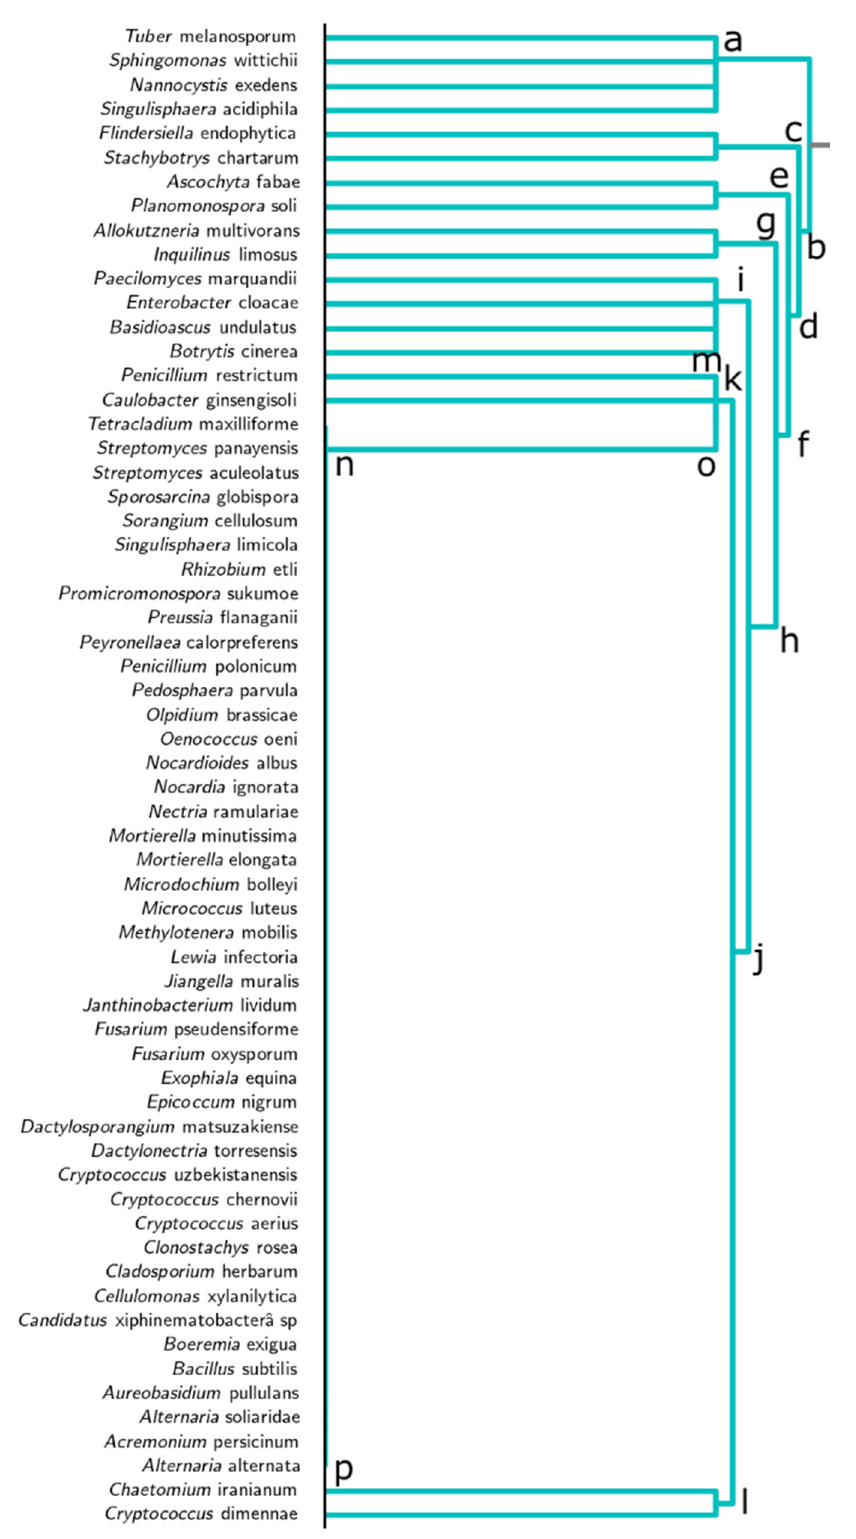
Figure 4. Dendrogram of the relationship between T. melanosporum and other fungal and bacterial species obtained by Russell & Rao coefficient and UPGMA. N. The dendrogram can be read as showing which species cluster together at increasing similarity thresholds: at the lowest level (left-hand side of Figure 4), only the most